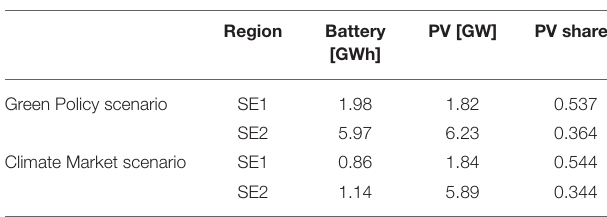
TABLE 3 | Sizes of PV and battery installations obtained from Goop et al. (submitted) and utilized for the modeling in both the System case and Household case, as given for the Green Policy and Climate Market